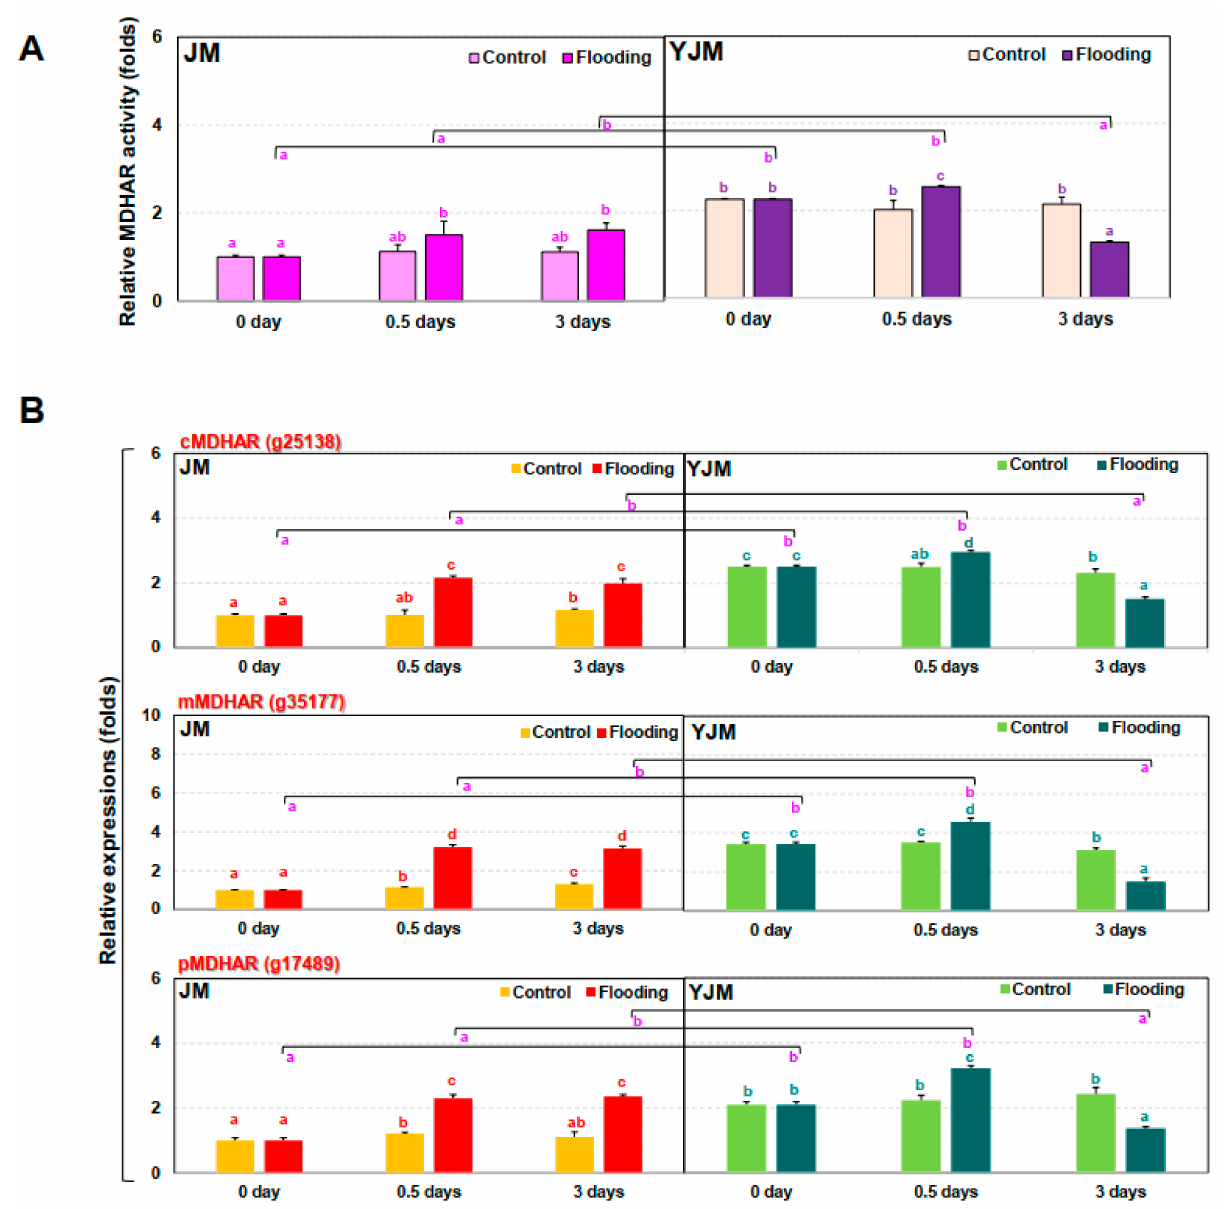
Figure 4. Changes in MDHAR activity and MDHAR gene expression in sweet potato cultivars treated with flooding stress for 3 d. ( A ) Relative MDHAR activity in each cultivar after 0, 0.5, or 3 d of flooding treatment. ( B ) Expression of MDHAR genes in each cultivar after 0, 0.5, or 3 d of flooding treatment. c MDHAR : cytosolic MDHAR ; p MDHAR : peroxisomal MDHAR ; m MDHAR : mitochondrial MDHAR . Different letters represent statistically significant differences between control and flooding treatment, and between flooding-treated JM and YJM, determined using two-way ANOVA with the LSD post hoc test; p <